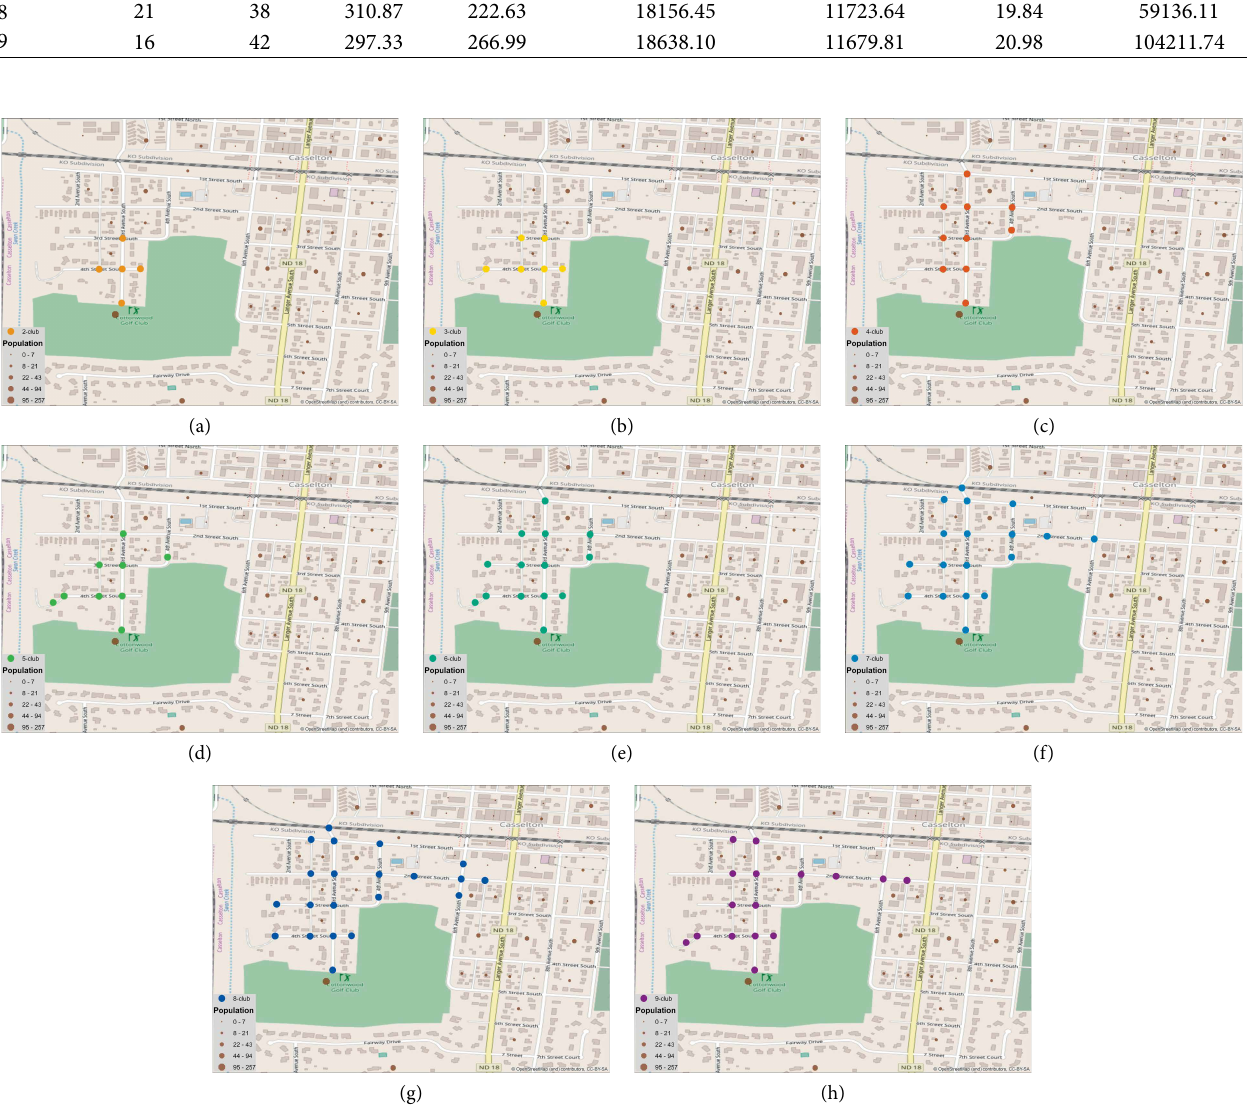
Figure 6: The 𝑘 -clubs obtained from the heuristic for the city of Casselton. The results are for 푘 = 2, . . . , 9 starting from the top left (for 푘 = 2 ) and ending in the bottom right (for 푘 = 9